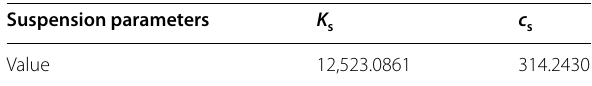
Table 1 Optimized suspension parameters Suspension parameters